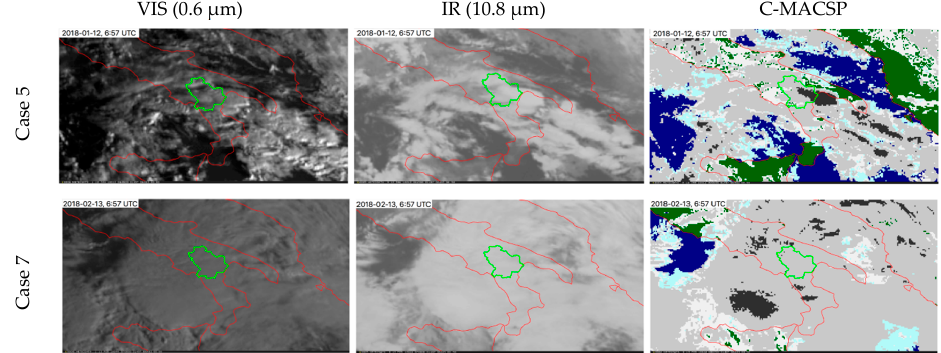
Figure 3. MSG-SEVIRI images at VIS (Visible) 0.6 µm (left column) and IR (InfraRed) 10.8 µm (middle column) and C-MACSP maps (right column) for case 5 (top row) and 7 (bottom row). C-MACSP: clear sea (blue), clear land (green), high thin cloud (cyan), low/middle cloud (white), high thick cloud (light grey) and convective cloud (dark grey).